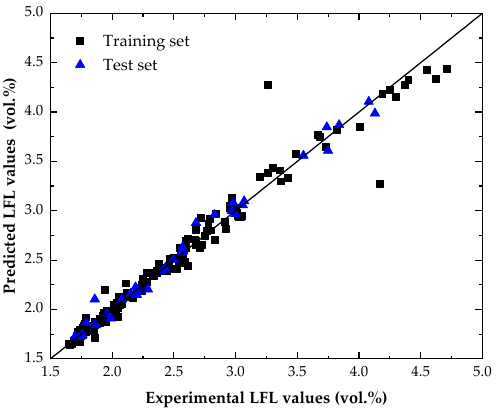
Figure 3. Correlation between the predicted and experimental LFL values for both the training and test sets.